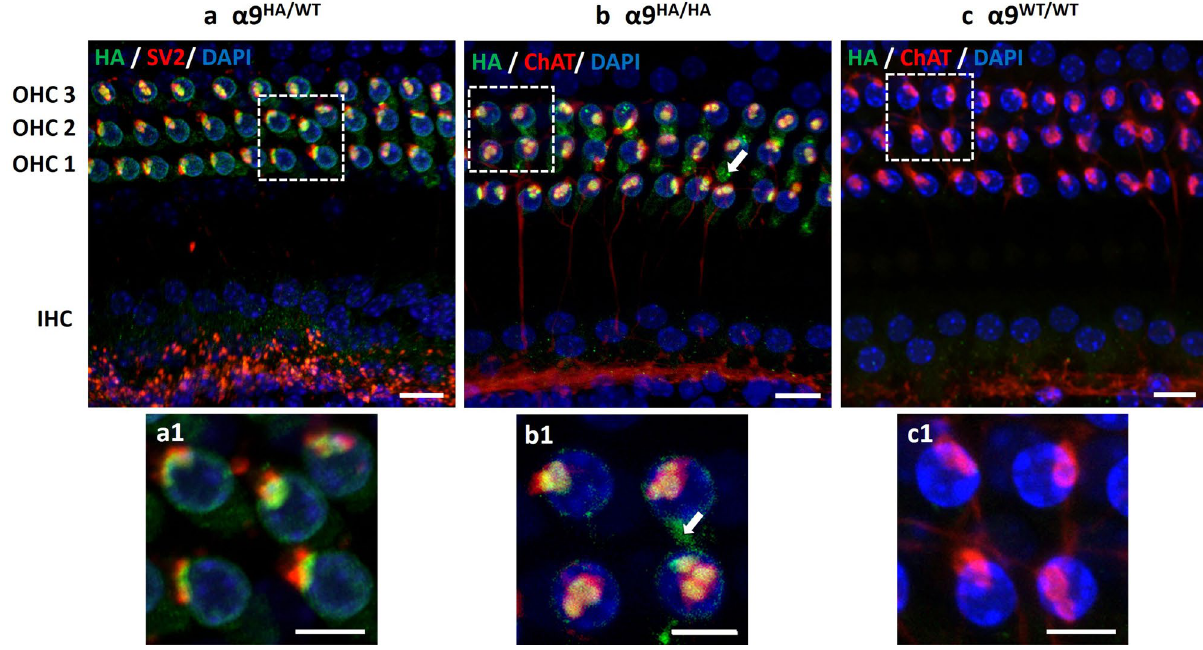
( b ) and α9 WT/WT ( c ) show the MOC terminals (red) juxtaposed to immunosignal clusters for HA tag. Note a clear absence of immunolabeling for HA tag in WT cochlea ( c ). Nuclei are visualized by DAPI staining (blue). Subcuticular immunopuncta in OHCs is indicated by arrows ( b , b1 ). Insets represent magnified areas marked by squares in images ( a )–( c ). Scale bar: ( a )–( c ) 10 µm, insets ( a1 )–( c1 ) 5 µm. (α9 WT/WT N = 5, α9 HA/HA N = 16, α9 HA/WT N =